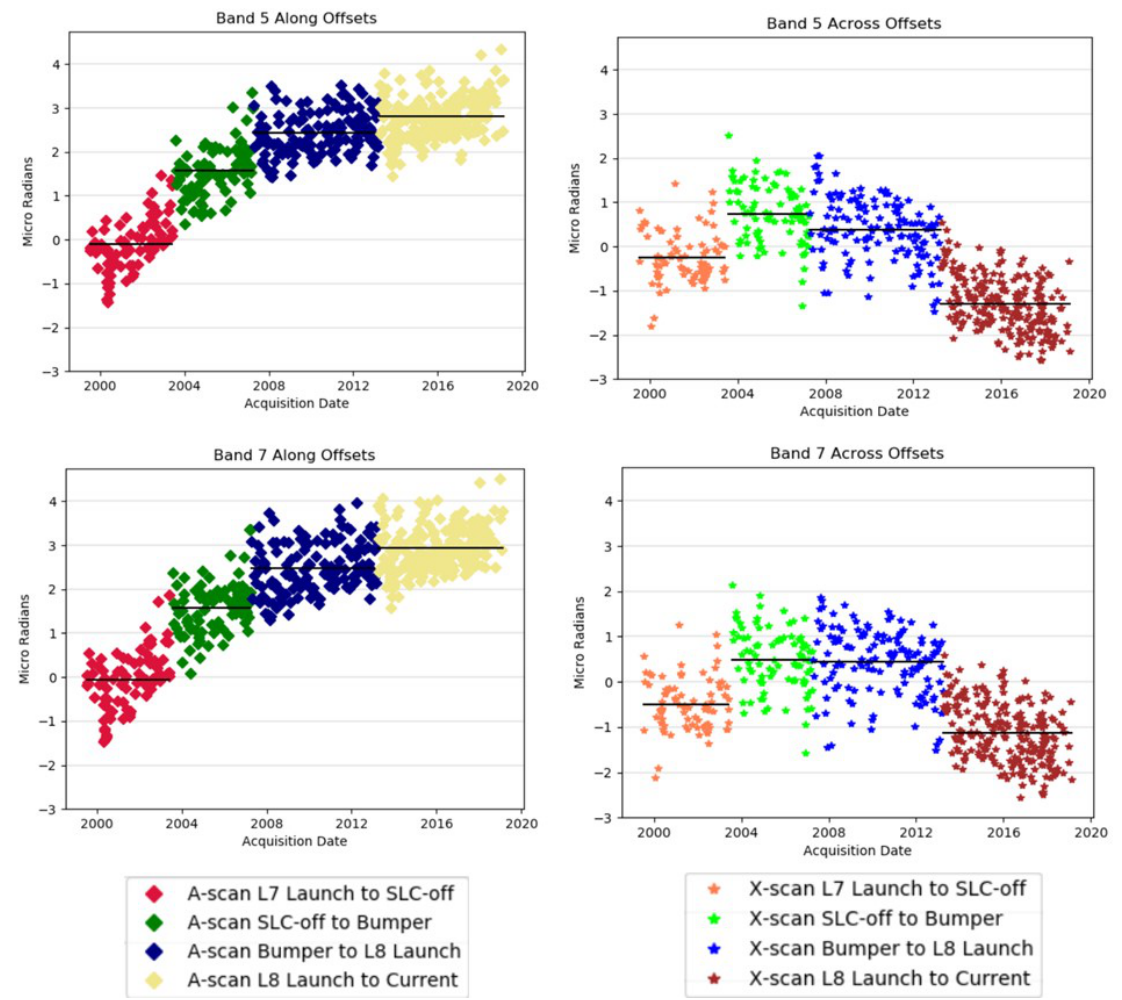
Figure 9. Band 5 and 7 focal plane measurements for Collection 1 data are shown. Values are color-coded to represent time frames, which will be broken out for calibration. These color-coded time periods will have the same corrections applied across the time range. A-scan refers to the along scan direction of the instrument, while X-scan refers to the across scan direction of the instrument.